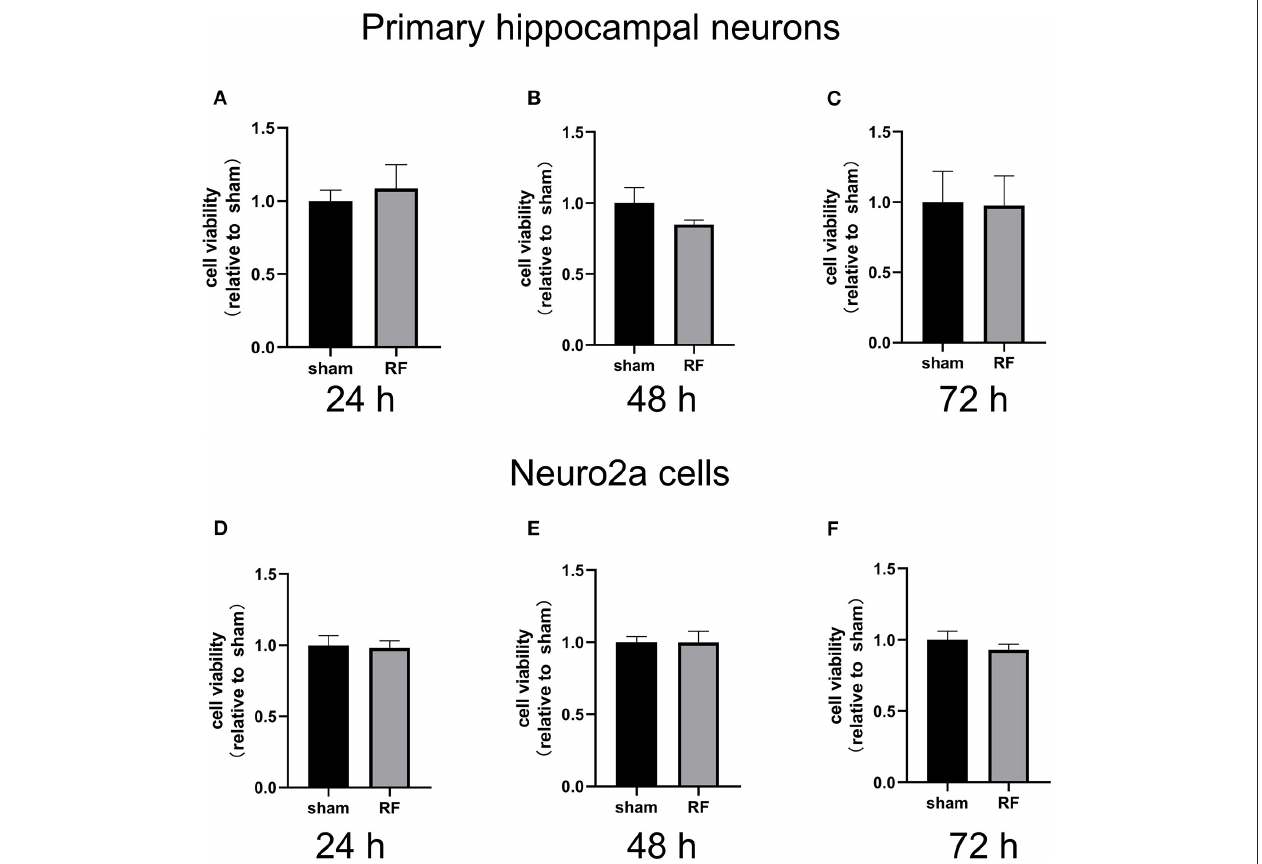
FIGURE 1 | Effects of RF-EMR exposure on neuronal cell viability. Cell viability was determined using a CCK-8 assay in primary mouse hippocampal neurons from C57BL/6 mice (A–C) and Neuro2a cells (D–F) irradiated by 24-, 48-, and 72-h 1,800 MHz RF-EMR at 4 W/kg. Data are represented as fold changes relative to sham from three independent experiments. The values are presented as the means ± SEM. Student’s t -test was performed to compare